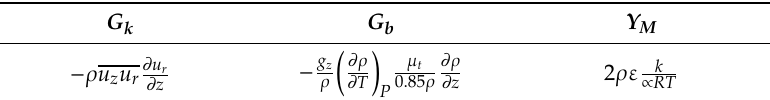
Table 3. Terms in continuum